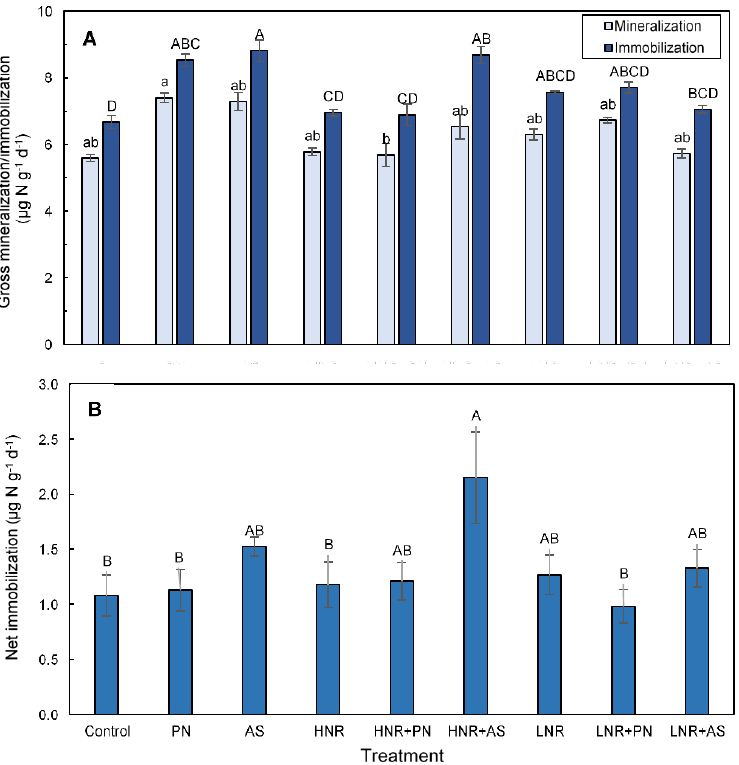
Figure 8. Gross mineralization/immobilization ( A ) and net immobilization ( B ) measured at five intervals (7, 14, 30, 45, and 60 d) during a 60 d aerobic incubation involving an unamended control and the following eight treatments: potassium nitrate (PN), ammonium sulfate (AS), high N residue (HNR) with or without PN (HNR + PN) or AS (HNR + AS), and low N residue (LNR) with or without PN (LNR + PN) or AS (HNR + AS). Values reported as a mean with standard error bars representing duplicate data collected before and after a 3 d incubation with ( 15 NH 4 ) 2 SO 4 . Treatments do not differ significantly ( p < 0.05) when bars are accompanied by the same lowercase (mineralization) or uppercase (immobilization) letter.